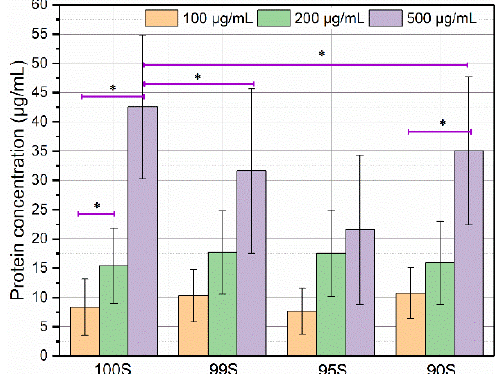
Figure 5. The concentrations of bovine serum albumin (BSA) adsorbed on 100S, 99S, 95S, and 90S after incubation in BSA solutions for 2 h at different BSA concentrations (100, 200, and 500 µ g/mL, respectively). Three technical repeats ( n = 3) were carried out within each experiment that was repeated in triplicate ( N = 3). Data are presented as mean ± SD and * indicates p <